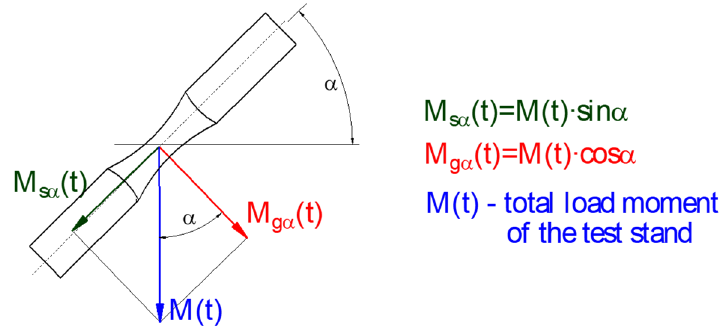
Figure 3. The load scheme of the fatigue test stand MZGS 100.